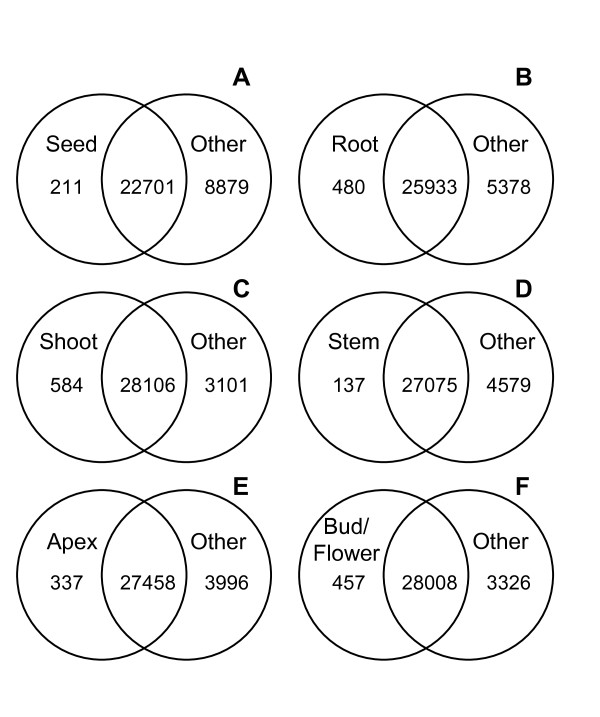
Tobacco tissue-specific gene expression. Venn diagram comparing genes identified as expressed in seed (TTI 1; A), root (TTI 2; B), shoot (TTI 3; C), stem (TTI 4; D), apex (TTI 5; E) and bud/flower (TTI 6; F) samples versus those identified as expressed in any of the other 5 tissue types.